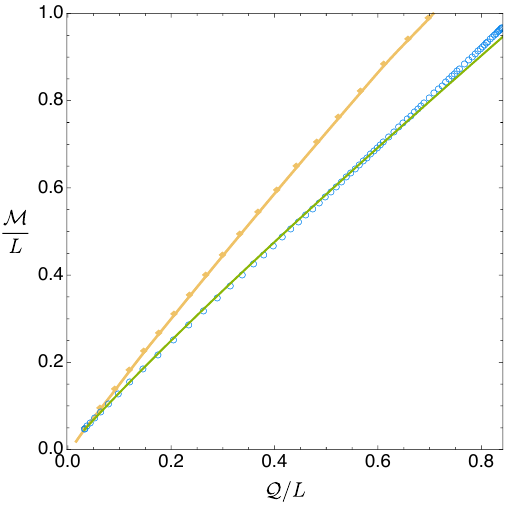
= 0 . 05 and e = 2 . 3 . + and small (cid:15) ( i.e. +